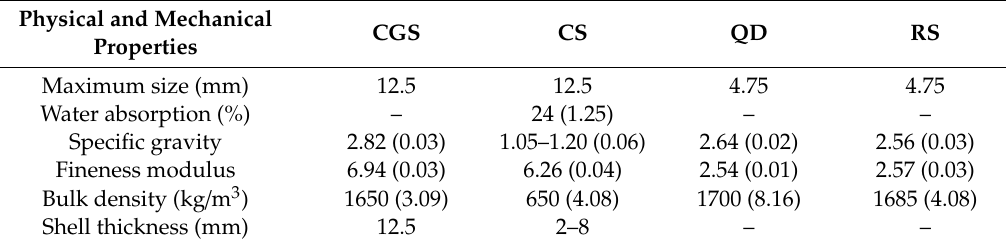
Table 1. Basic properties of fine and coarse aggregates used.